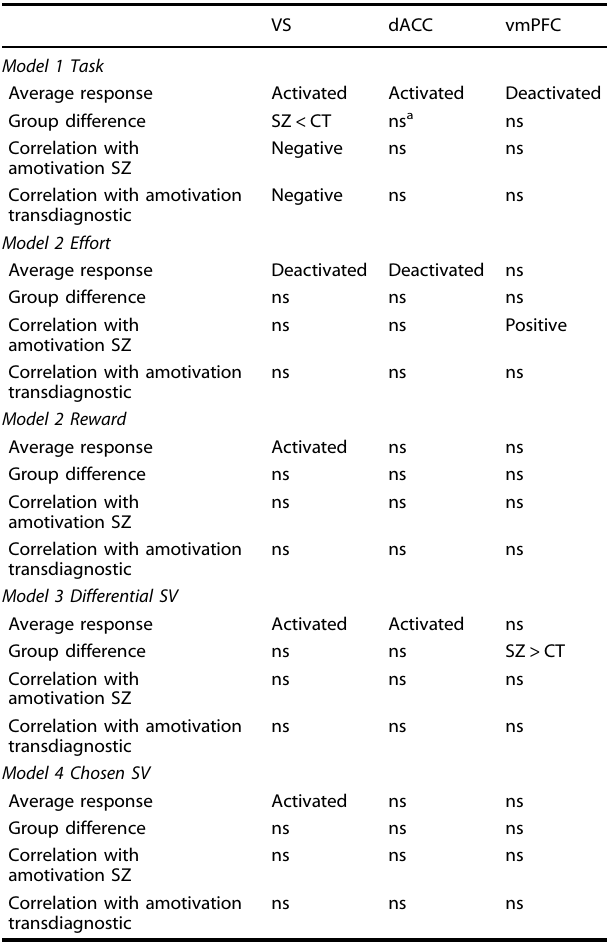
Fig. 4 Comparison of two models for subjective value. Bilateral VS was activated by both differential subjective value (SV, HARD – EASY) ( a ), and by SV of the chosen option ( b ). Signi fi cance is determined within VS ROI. Display threshold is set below signi fi cance levels to illustrate bilaterality of the chosen value effect (signi fi cant on right, trend on left). Table 2. Summary of fi ndings for each contrast tested in the primary VS ROI and secondary (dACC, vmPFC)